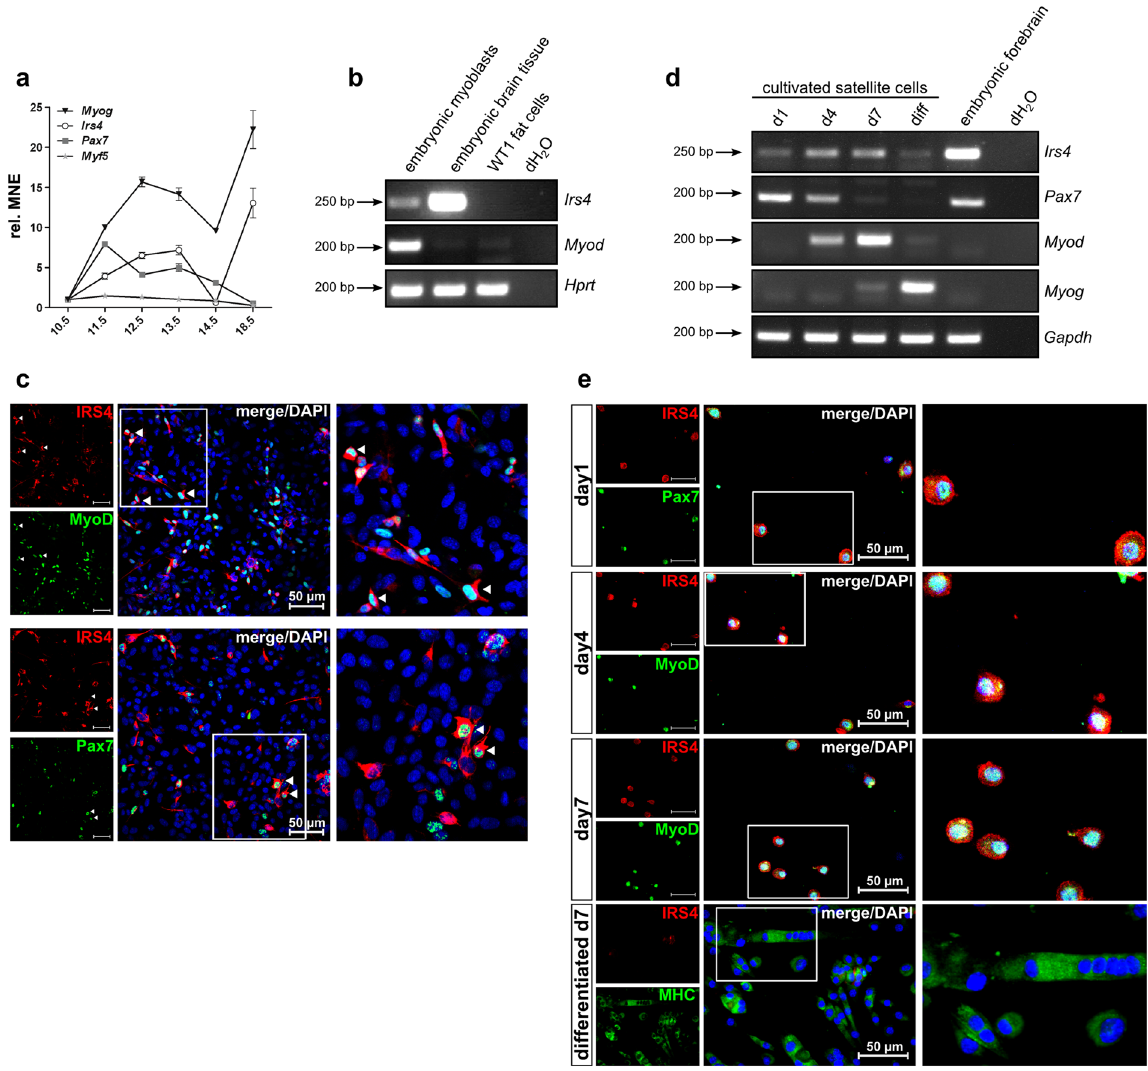
Figure 4. In vivo expression of IRS4 in mouse limbs, primary myoblasts and satellite cells. ( a ) IRS4 is expressed during mouse limb development. RNA from mouse limbs of indicated embryonic developmental stages was isolated, reverse-transcribed and subjected to gene expression analyses via qRT-PCR. Data points summarise triplicate measurements and depict mean normalised expression (MNE) ± SEM representative for 2 independent experiments. ( b ) IRS4 is expressed in cells freshly isolated from foetal limb skeletal muscle. Primary mouse myoblasts were isolated from E18.5 limb muscles. PCR shows IRS4 transcript in myoblasts; E14.5 embryonic brain tissue served as positive control, WT1 fat cells as negative control. ( c ) Immunofluorescence staining of primary E18.5 mouse myoblasts using indicated specific antibodies shows IRS4/MyoD and IRS4/Pax7positive cells (see arrows); nuclei were stained using DAPI. ( d ) IRS4 is expressed in cultured satellite cells. Mouse satellite cells were isolated from P7 limb muscles, cultured for the indicated days and subjected to PCR analyses. Embryonic forebrain served as positive control. ( e ) Immunofluorescence staining of cultured mouse satellite cells using indicated specific antibodies reveals expression of IRS4 in postnatal muscle precursor cells; nuclei were stained using